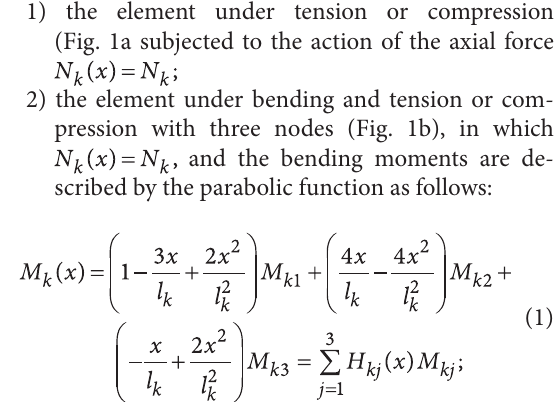
Fig. 1. Finite elements: a – the element under tension or compression; b – the second-order element or the element under bending and tension